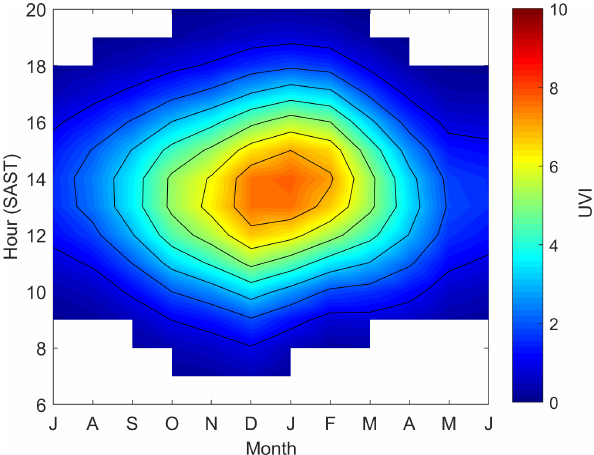
Figure 2. The UVI climatology for all sky conditions at Cape Point. The x axis starts with the month of July and ends with